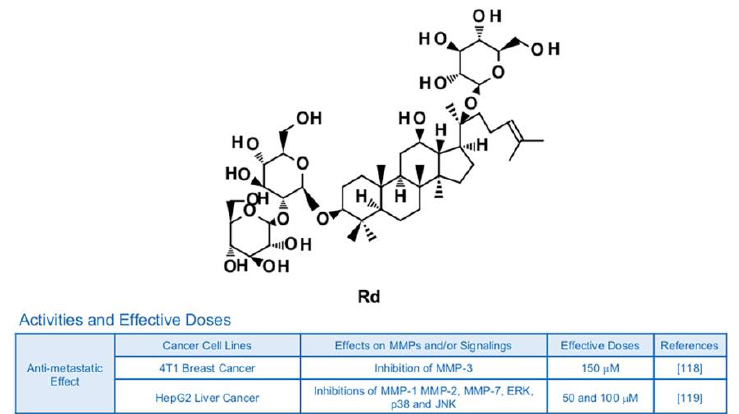
Figure 9. Summary of activities of ginsenoside Rd. Structure of Rd and its effects on MMPs and/or signalings [118,119].